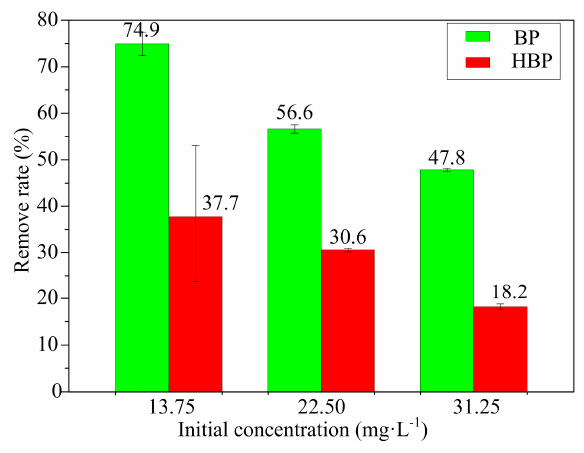
Figure 2. BP and HBP removal by the UV/H 2 O 2 process.